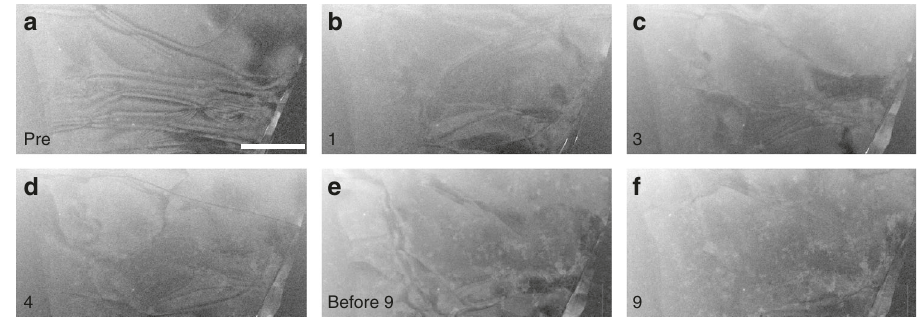
Fig. 5 Structural changes through many intercalation/deintercalation cycles. a A pristine graphite fl ake prior to any intercalation. b – f The same graphite fl ake at the end of complete intercalation/deintercalation cycles 1, 3, and 4, at the beginning of cycle 9, and at the end of cycle 9, as indicated in the bottom left corner. During cycles 5 – 8 other areas of this fl ake were imaged at high magni fi cation. See Supplementary Movie 3. The scale bar is 500